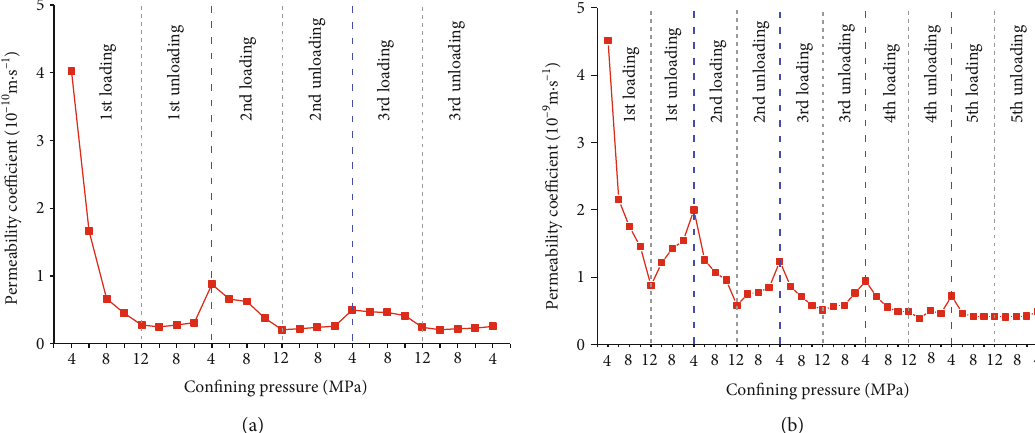
Figure 7: Variation of permeability coe ffi cient under the full-path of loading-unloading the con fi ning stress for fractured (a) sandstone and (b) granite specimens.